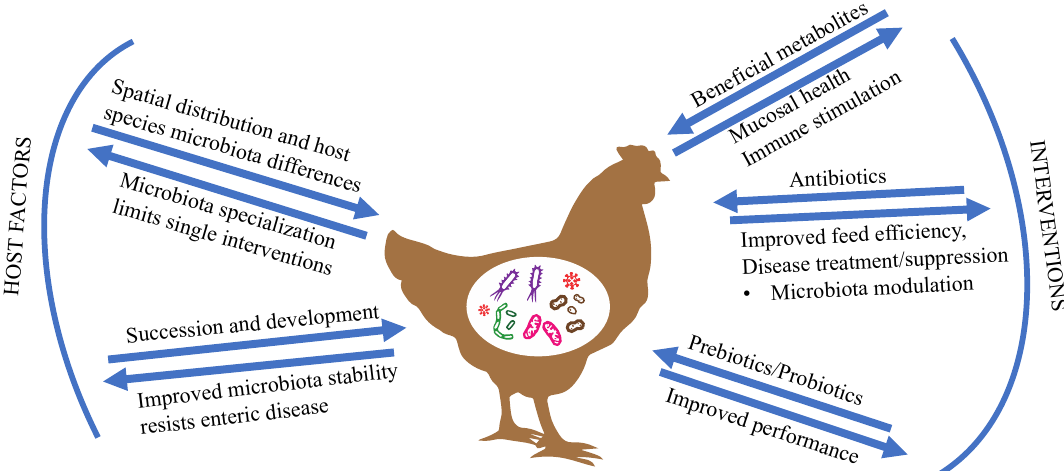
Figure 1. Factors influencing the poultry microbiota composition and potential outcomes that influence animal health. Microbiome factors discussed in the review that influence the composition and/or functions of the microbiota are indicated with arrows pointing inward. Outward pointing arrows suggest potential or desired outcomes to the factors.